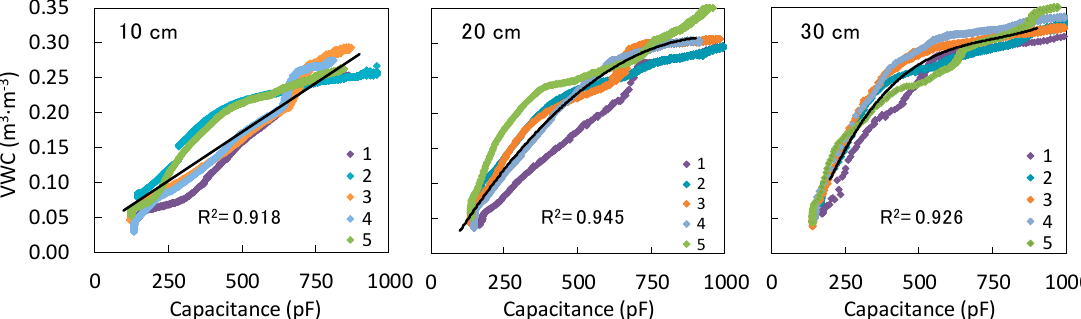
Figure 6. Relationship between volumetric water content (VWC) and electrical capacitance obtained from the calibration experiments. The different colors and numbers indicate the repeated count. The black lines are the approximate equations.